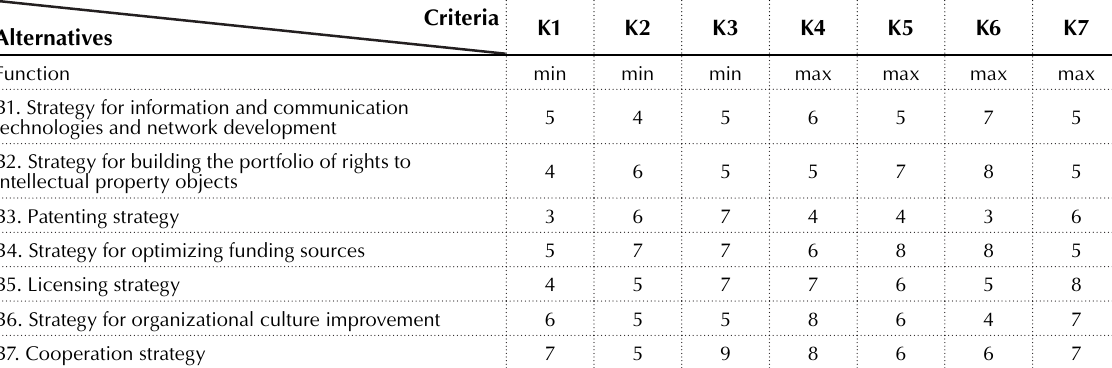
Table 6. Output data (decision matrix) on ranking the strategies for structural capital development by the TOPSIS